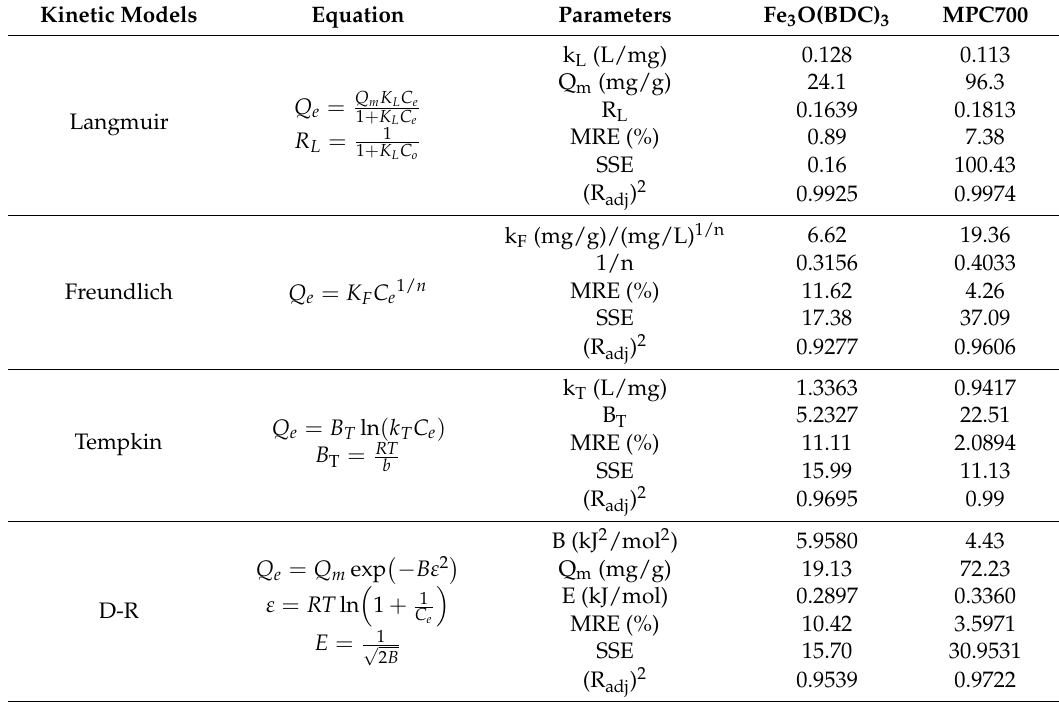
Table 5. Isotherm constants for the adsorption of CAP by MPC700 and Fe 3 O(BDC) 3 .